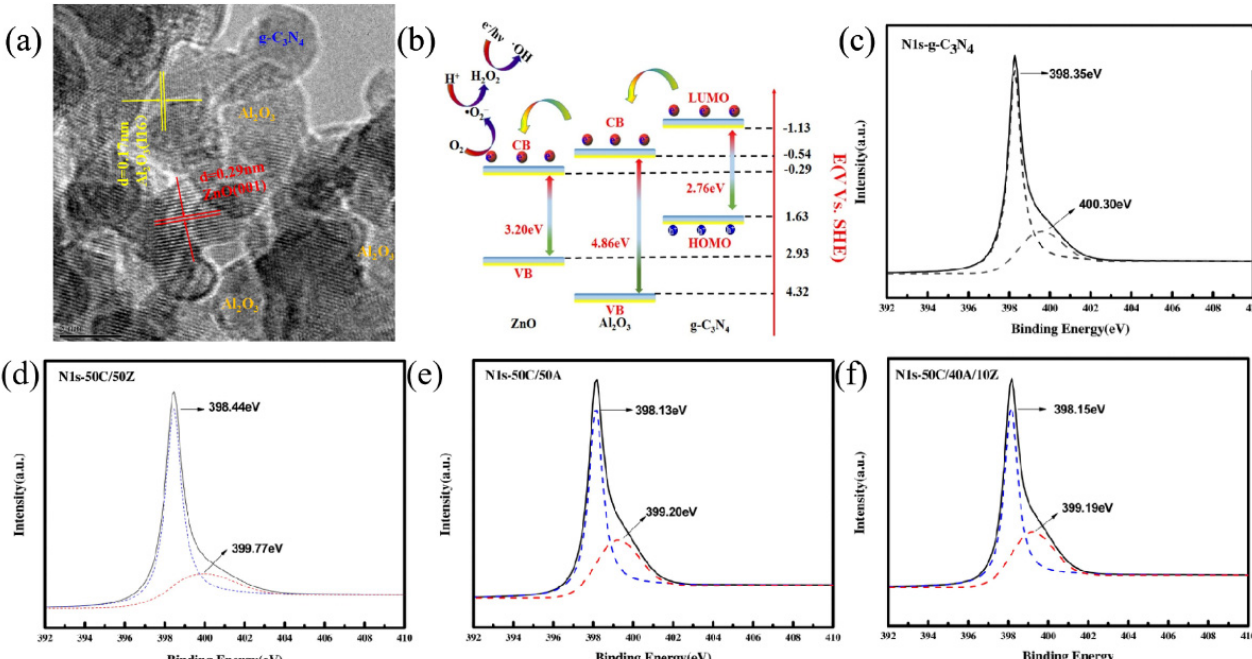
Figure 12. ( a ) HRTEM image of ternary g-C 3 N 4 /Al 2 O 3 /ZnO heterojunctions. ( b ) Cascade of electron transfer in ternary g-C 3 N 4 /Al 2 O 3 /ZnO heterojunctions under visible-light irradiation; high − resolution XPS spectra of ( c ) Al2p. ( d – f ) N1s of g-C 3 N 4 , 50C/50Z, 50C/50A and 50C/40A/10Z. Used with permission from [139]. Copyright 2017 Elsevier.